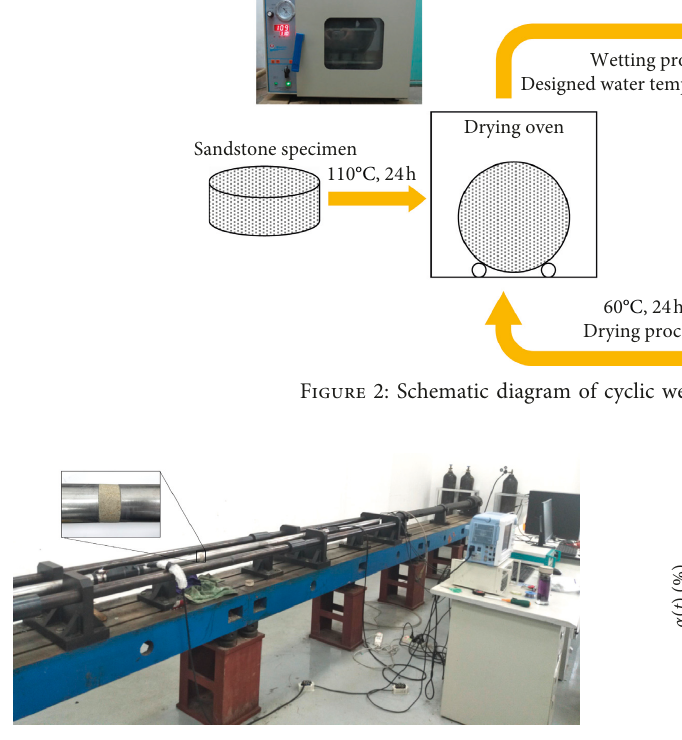
Figure 3: SHPB apparatus for dynamic uniaxial compressive tests.